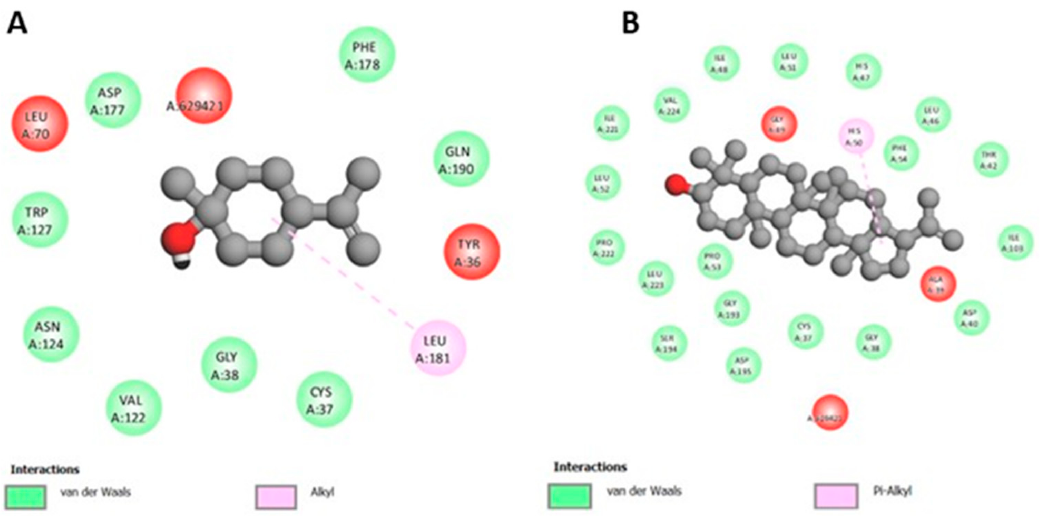
Figure 6. The interaction between tyrosyl-tRNA synthetase (TyrRS) and tested compounds. ( A ): Beta-terpineol; ( B ): 3-epimoretenol.